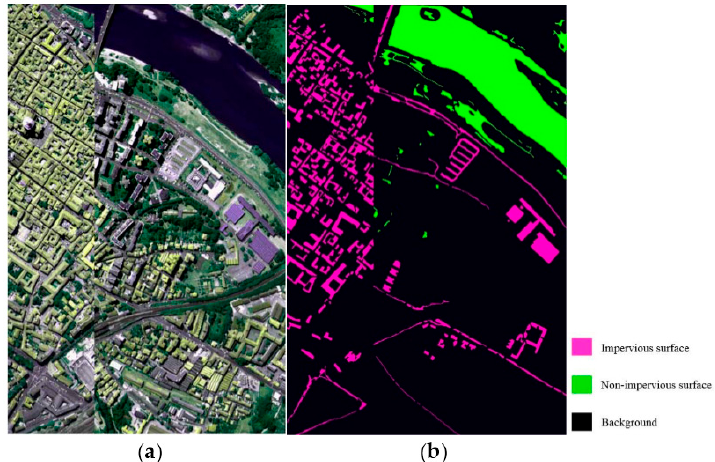
Figure 3. Center of Pavia: ( a ) false color composite image; and ( b ) the reference image.